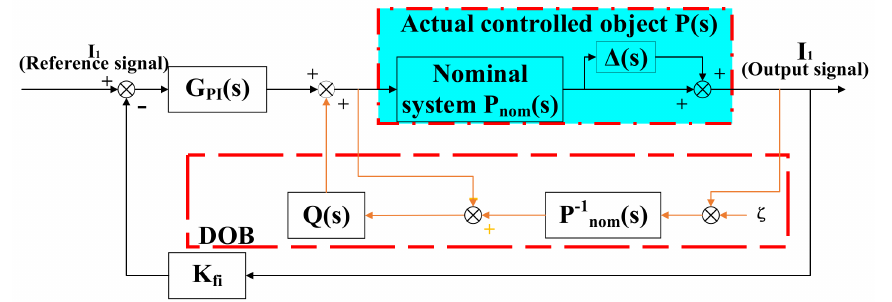
Figure 11. Equivalent control block diagram based on a disturbance